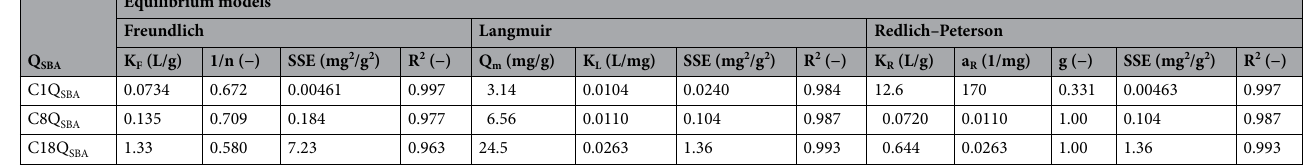
Table 3. Equilibrium model parameters for CBZ adsorption by Q SBA